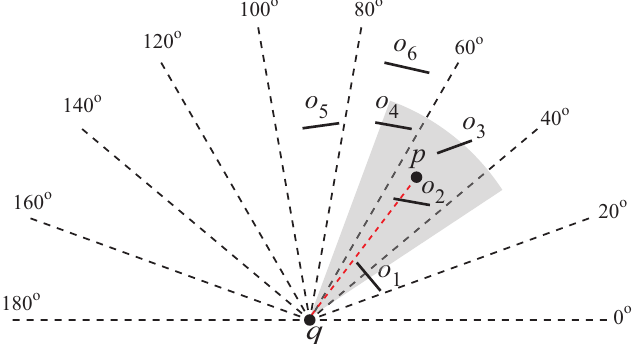
(cid:101) sections (i.e., θ S = 20 ◦ ). The gray area is q ’s view field. Figure 17. Split the 2D space into (cid:100) 360 ◦ 20 ◦ Note that the data space that covers 180–360 ◦ is omitted